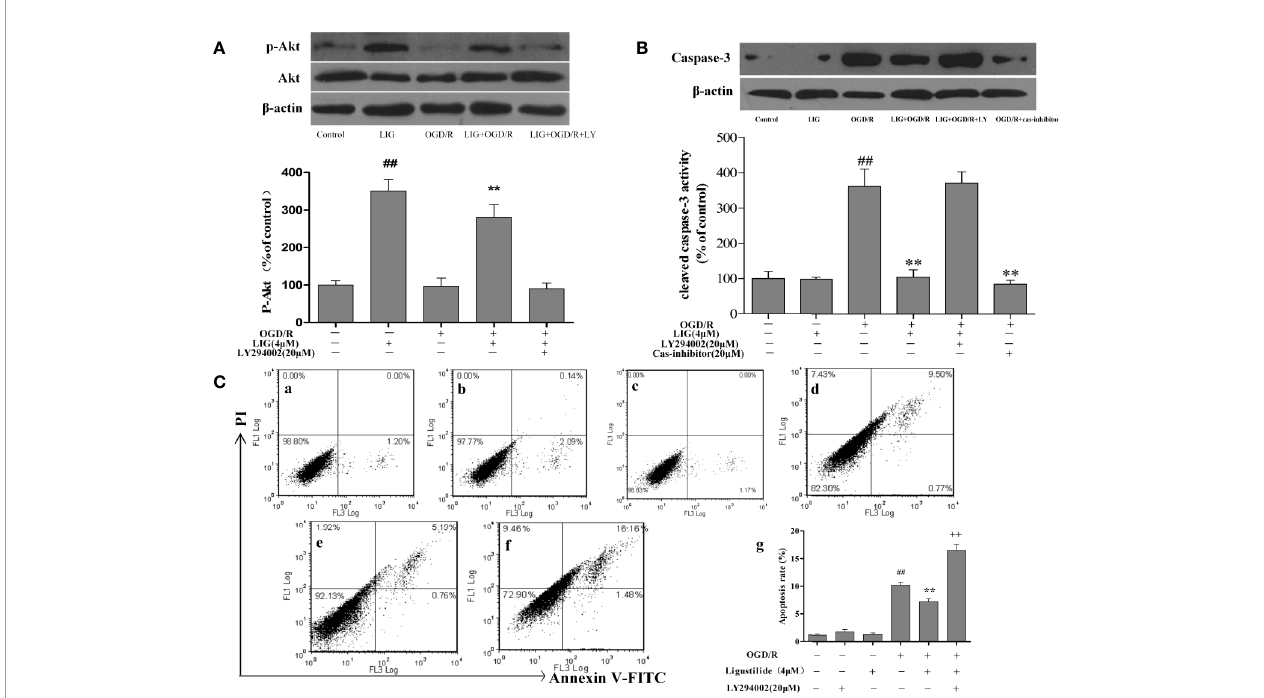
FIGURE 4 | Role of PI3K/Akt in the antiapoptotic effect by ligustilide. (A, B) Western blot image and the expression analysis of P-Akt and Caspase-3. (C) Apoptotic cells rate were detected by fl ow cytometry. (C-a) Control group; (C-b) 20 m M LY294002; (C-c) 4- m M LIG; (C-d) OGD/R; (C-e) 4 m M LIG+OGD/R; (C-f) 4- m M LIG +20 m M LY294002+OGD/R. (C-g) The apoptotic cell rate of each group. Data represent the mean ± SD of three independent experiments. ## P < 0.01 vs. control group;** P < 0.01 vs. group treated with OGD/R; ++ P < 0.01 vs. LIG+OGD/R